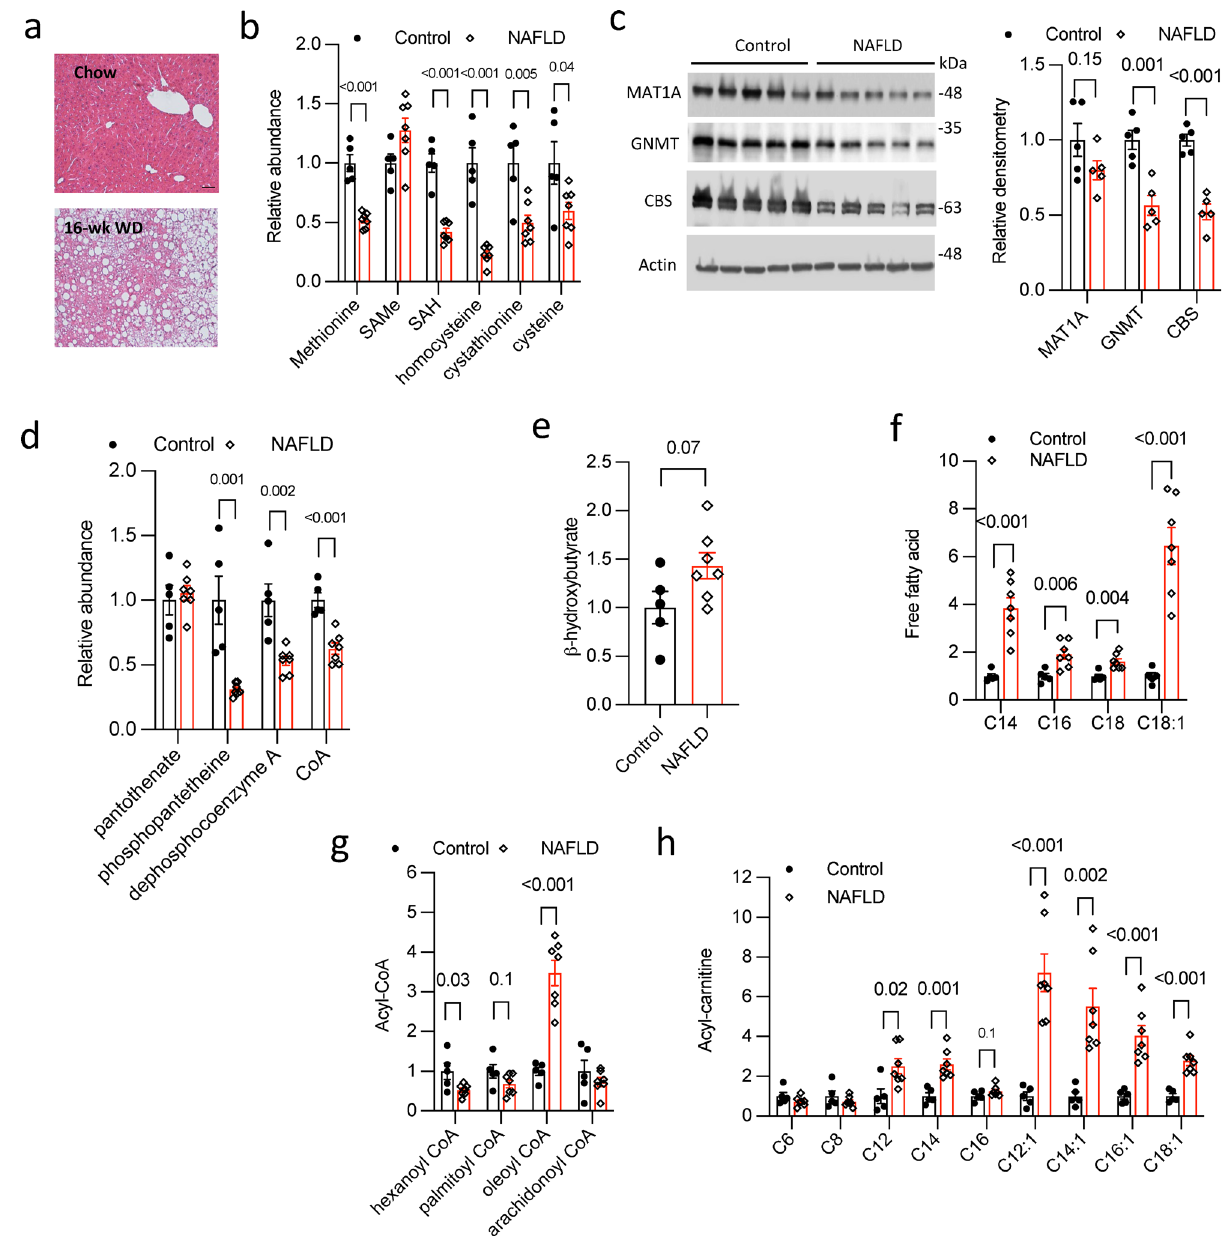
Fig. 7 | NAFLD is a cysteine and CoA insuf fi cient state that contributes to hepatic metabolic in fl exibility. a – h Male 10 weeks old C57BL/6J mice were fed chowdiet(Control)orWesterndiet(WD)for16weekstoinducenon-alcoholicfatty liver disease (NAFLD). Mice were fasted for 6h and euthanized. ( n =5 for Control, n =7 for NAFLD). a Representative liver H&E stain. Scale bar=50 µ m.